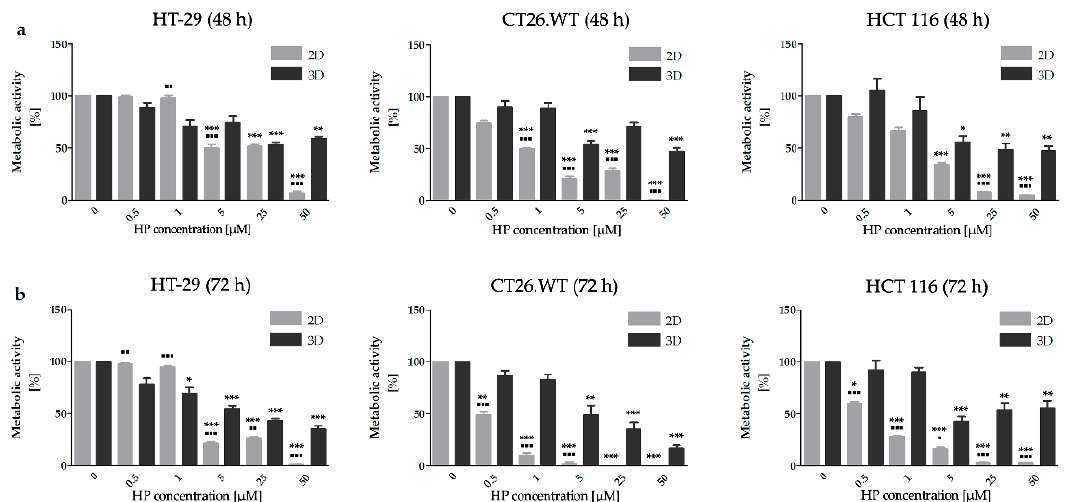
Figure 2. Metabolic activity in cell lines after treatment with HP. The 3D cell model is more resistant to HP treatment than the 2D cell model. Metabolic activity was assessed in all experimental cell lines 48 h ( a ) and 72 h ( b ) by MTT assay. The results are expressed as the mean value ± SD of three independent experiments. The experimental groups cultivated in 2D and 3D cell models were compared with the control group (* p < 0.05, ** p < 0.01, *** p < 0.001). The experimental groups cultivated in 2D cell models were compared with experimental groups cultivated in 3D cell models ( ▪ p < 0.05, ▪▪ p < 0.01, ▪▪▪ p < 0.001).